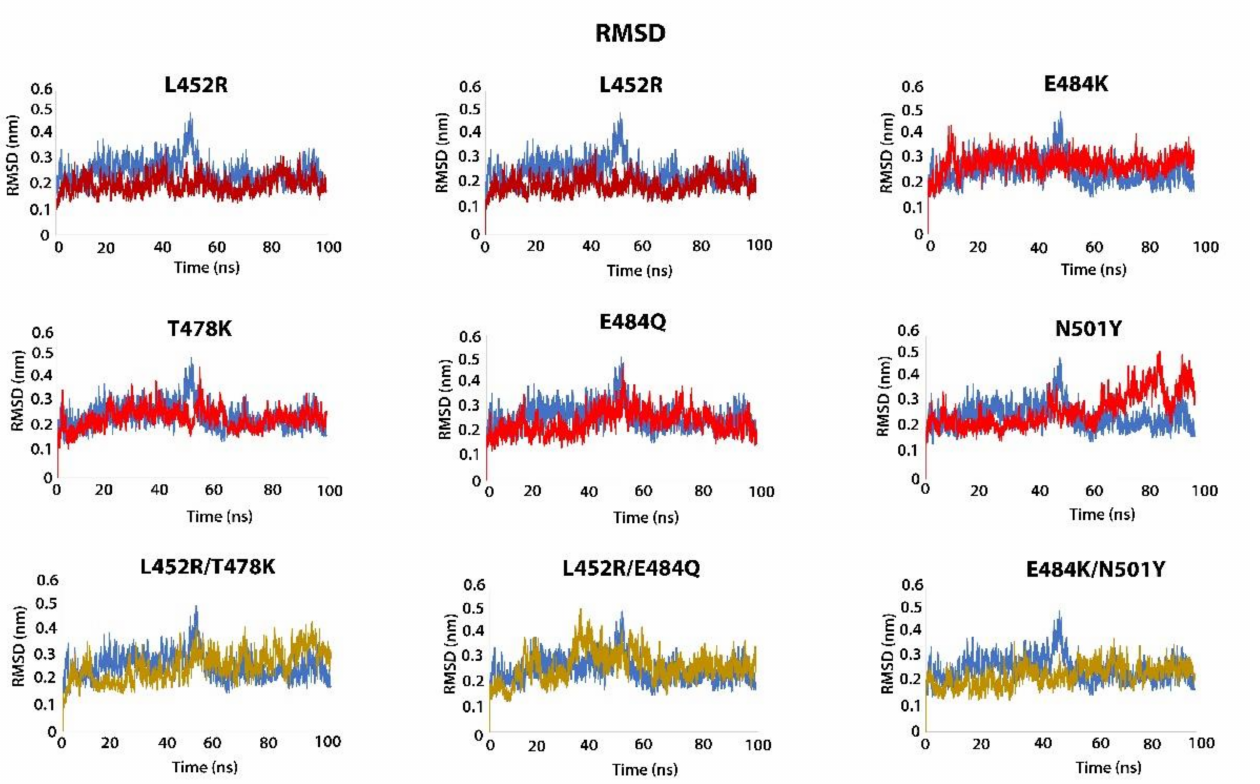
Figure 2. Dynamic changes of RBD structure by RMSD analysis. Blue: Wild-type, Red: single muta- tions (L452R, T478K, E484K, E484Y, N501Y); Yellow: double mutations (L452R/T478K, L452R/E484Q, E484K/N501Y). x -axis shows the simulation lasted time (100 ns); y -axis shows the RMSD value for the structures. The results show substantial differences between single- and double-mutated RBD